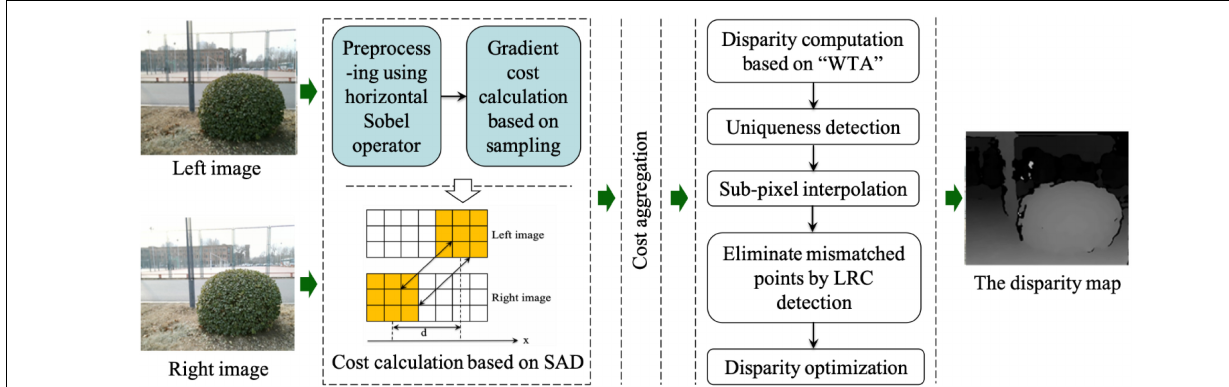
FIGURE 12 | Flow chart of the improved SGBM algorithm.